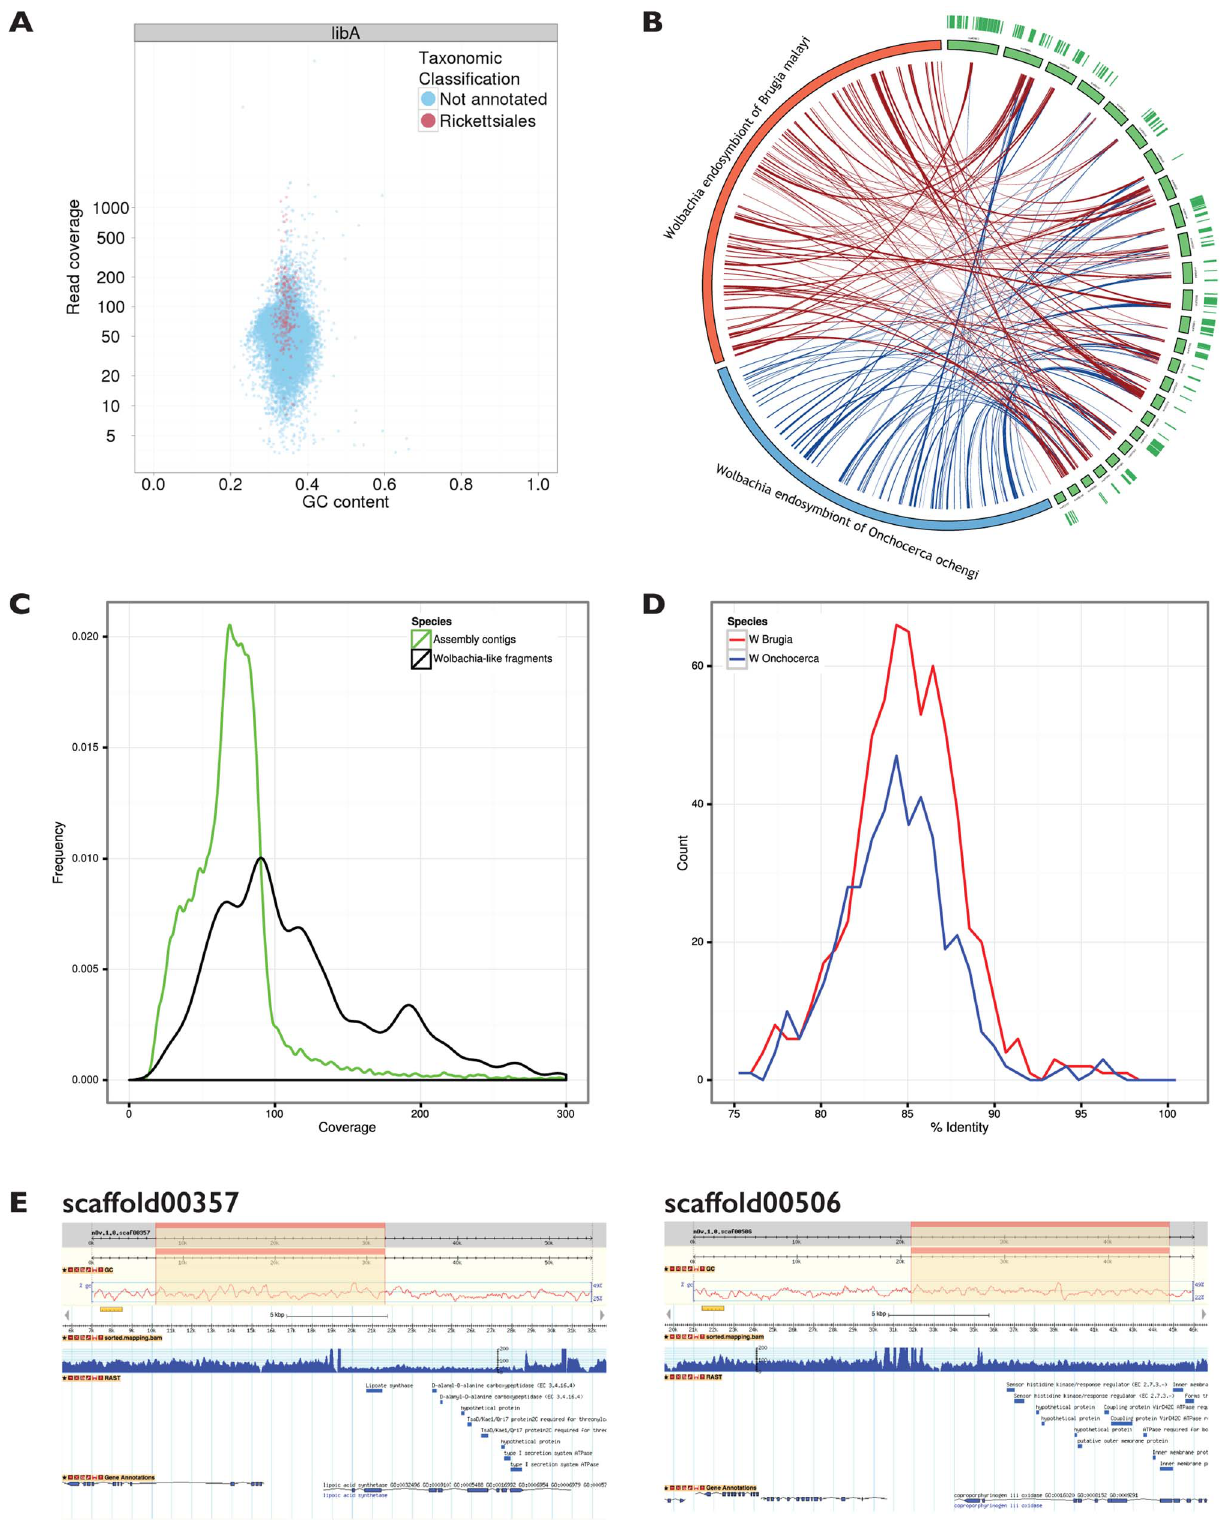
Figure 3. Wolbachia sequence in a Dictyocaulusviviparus genome assembly. A. Taxon-annotated GC%-coverage plot of the primary D. viviparus genome assembly, with contigs that have significant matches to Wolbachia proteins highlighted in red. A total of 193 contigs spanning 1 Mb (out of a total assembly span of 169 Mb) had significant similarity to Wolbachia . B. Circos plot comparing the 25 longest of the D. viviparus genome contigs that contained Wolbachia -like sequence to the genome of the Wolbachia endosymbionts of the filarial nematode Brugia malayi ( w Bm) [9] and Onchocerca ochengi ( w Oo). The arcs show BLASTn-derived matches between the contigs and the genome sequences. Transcripts from D. viviparus mapped to the assembly are reported as green lines in the outer circle of the figure. C. Frequency histogram illustrating the different